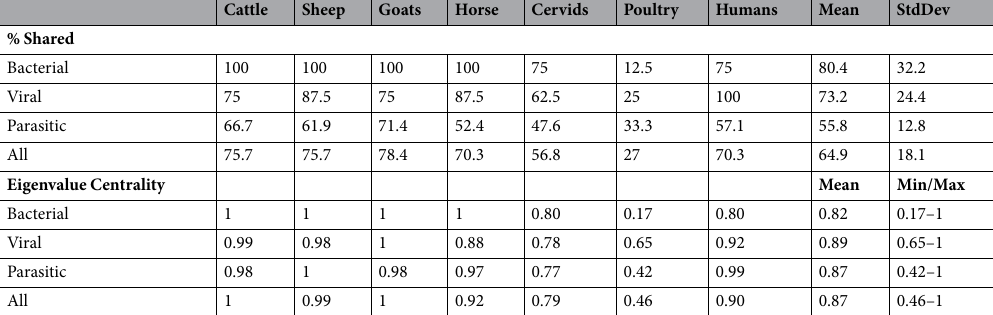
proportion of farms and rural populations co-occurring with wild pigs was then calculated for the years 2002, 2007, and 2012. We estimated the increase in the number of farms and human populations co-occurring with wild pigs using linear regression.